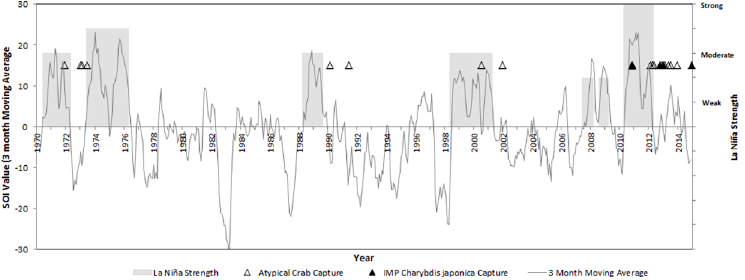
Fig 1. Southern Oscillation Index (SOI) time series between 1970 and 2014. La Niña events (grey highlight) and their strength, as indicated by the Bureau of Meteorology, since 1970. Captures of tropical portunids in South-Western Australia indicated by hollow triangles and sightings of Charybdisjaponica are indicated by black